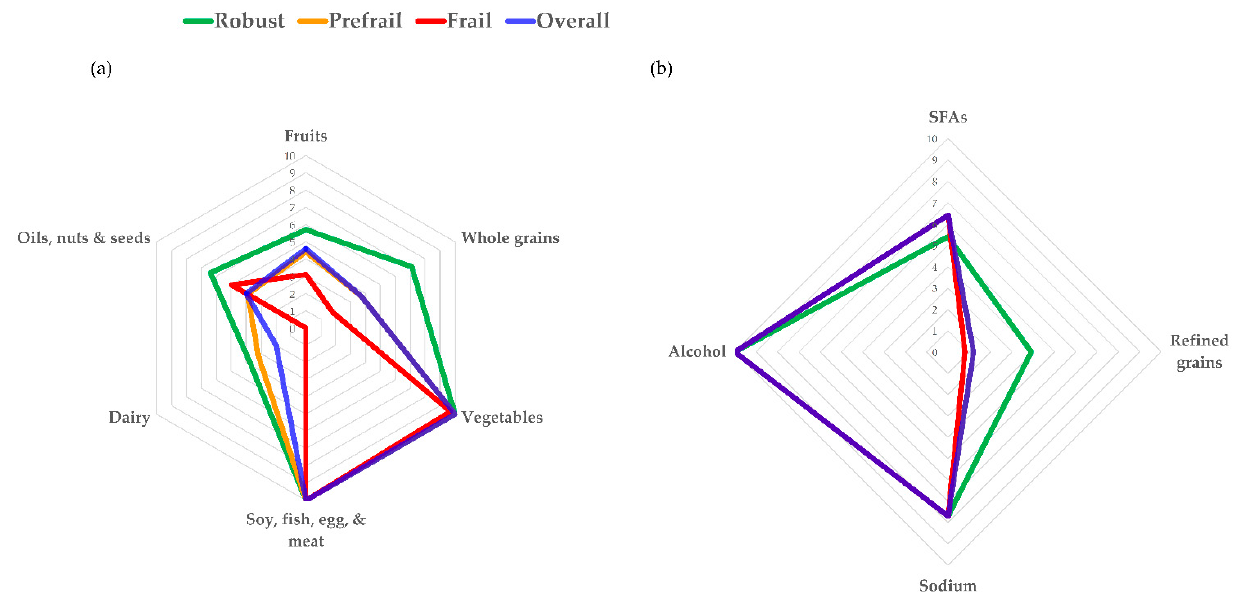
Figure 1. Radar charts for Taiwanese Healthy Eating Index (T-HEI) score distribution for overall participants and across frailty status in ( a ) T-HEI integrated scores, based on six food groups from DFGs, and ( b ) T-HEI moderations components scores.